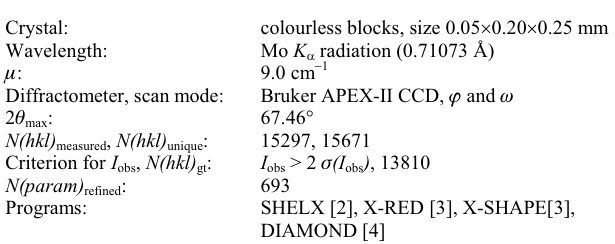
Table 1. Data collection and